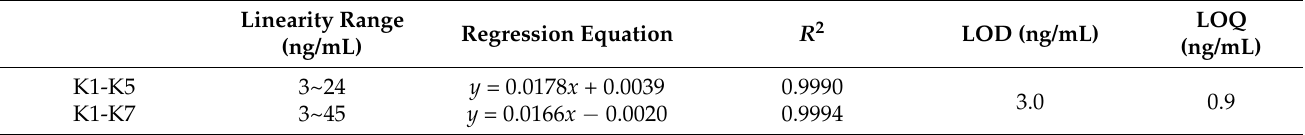
Table 3. Calibration curves, LOD and LOQ for NMBA.